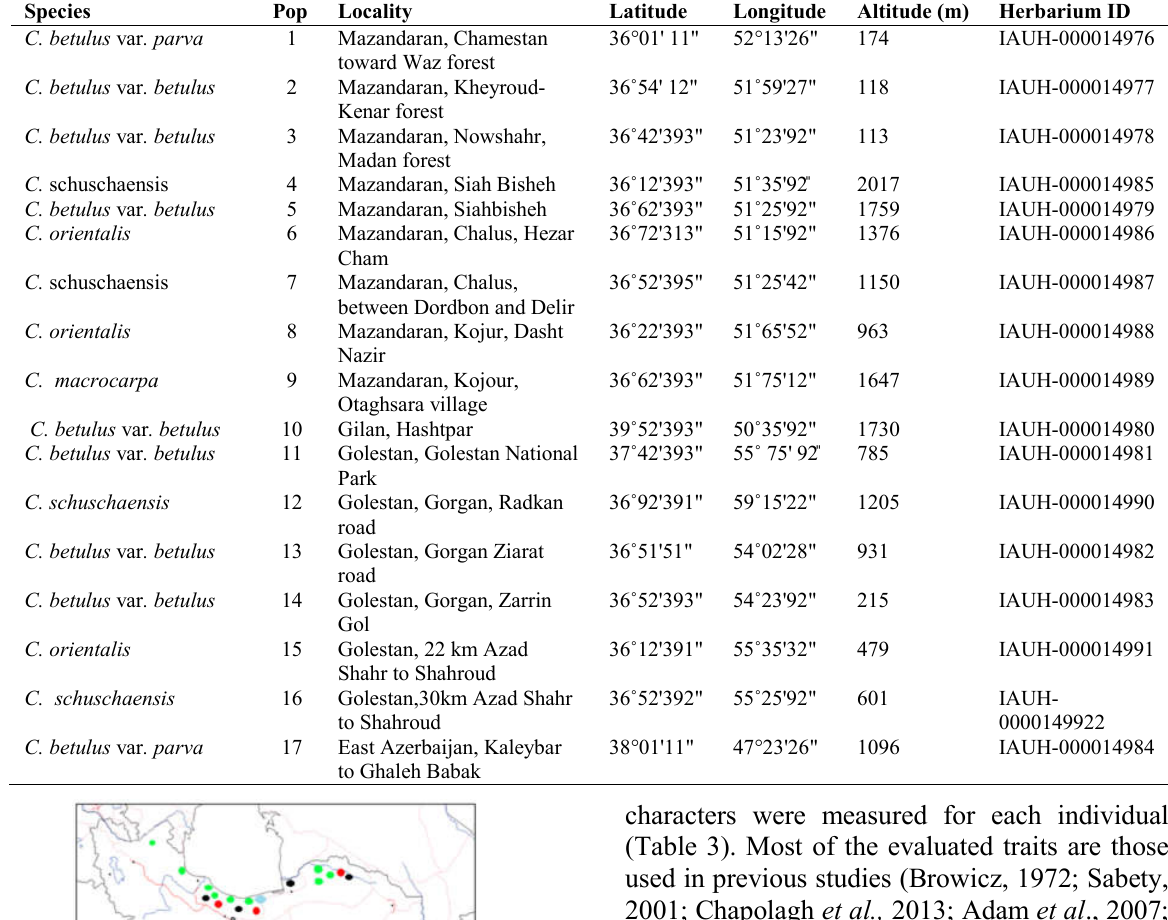
Table 2. Location and herbarium accession numbers of the studied populations of Carpinus species collected by Riyahee in Iran.